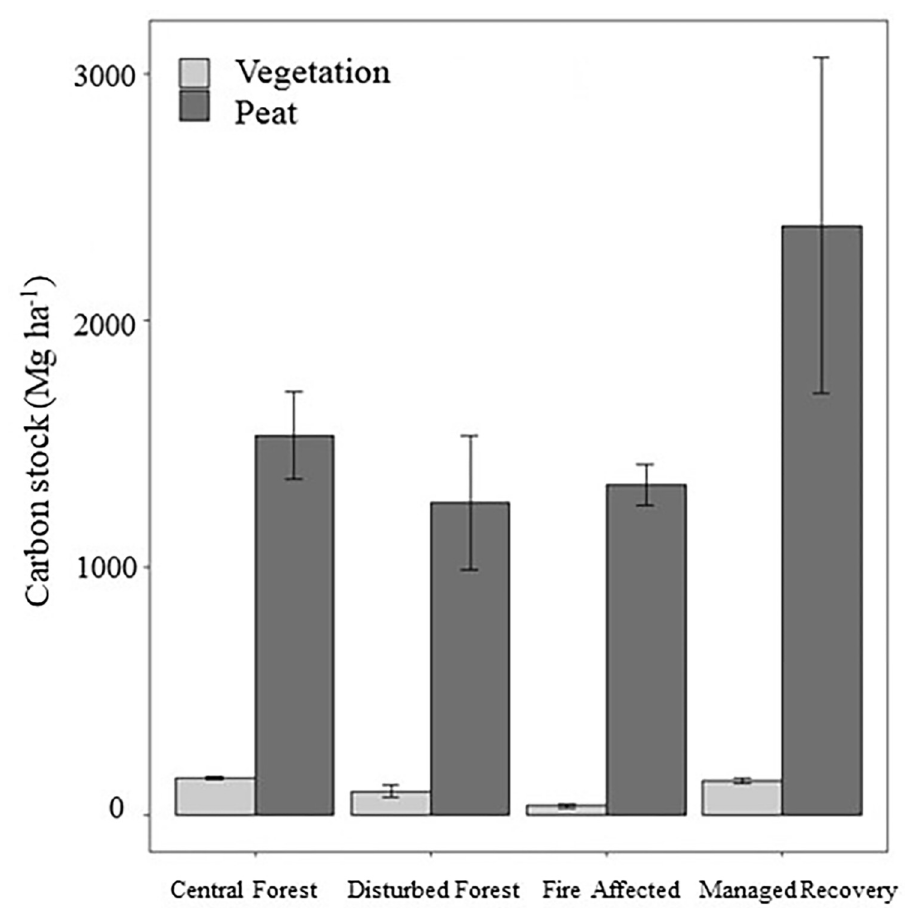
Fig 1. Carbon storage in the vegetation and peat soil for each of the four forest condition classes, mean and error bars (standard error of the mean) shown.